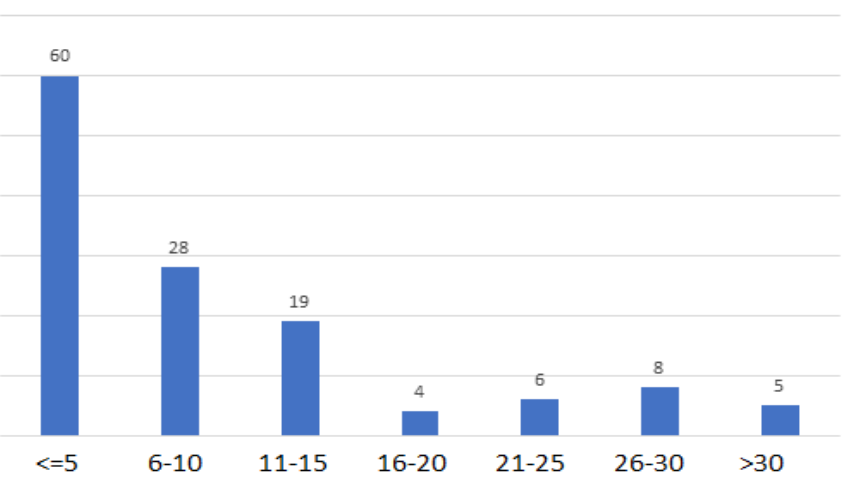
Figure 3. Day of onset of vascular ocular event divided into segments of five days.